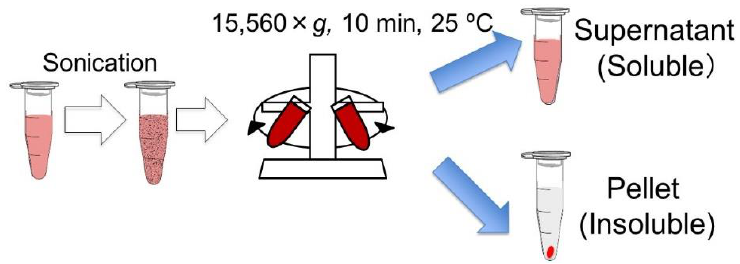
Figure 1. Scheme of preparation of inactivated cells and cell components.